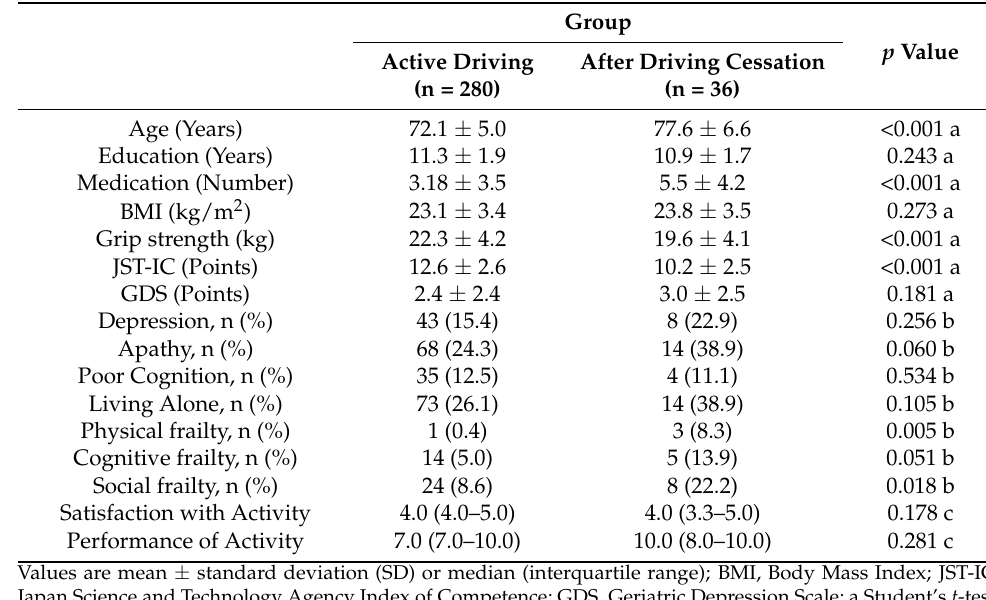
Table 3. Characteristics in the active driving group and the after driving cessation group in women.